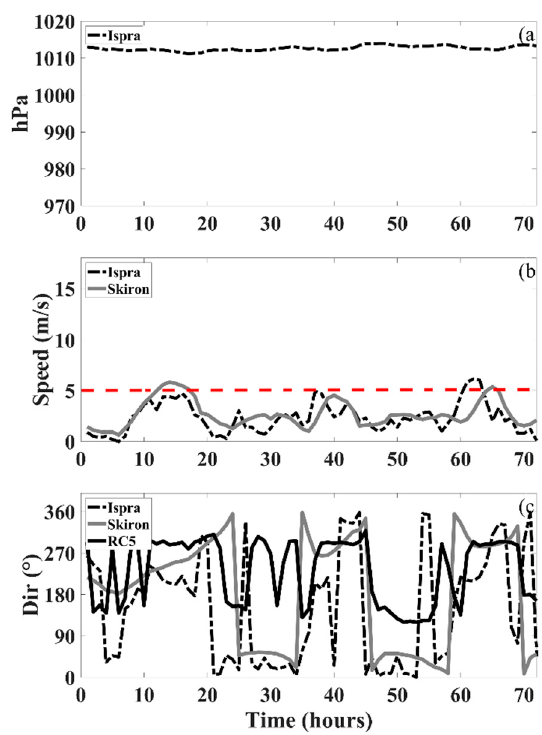
Figure 6. Time series of ISPRA, HFr and SKIRON/Eta model data during the event occurred on 4–6 August 2009 with occasional gusts > 5 m/s. The panels show: ( a ) atmospheric pressure (hPA), ( b ) wind speed (m/s) and ( c ) wind direction (°).